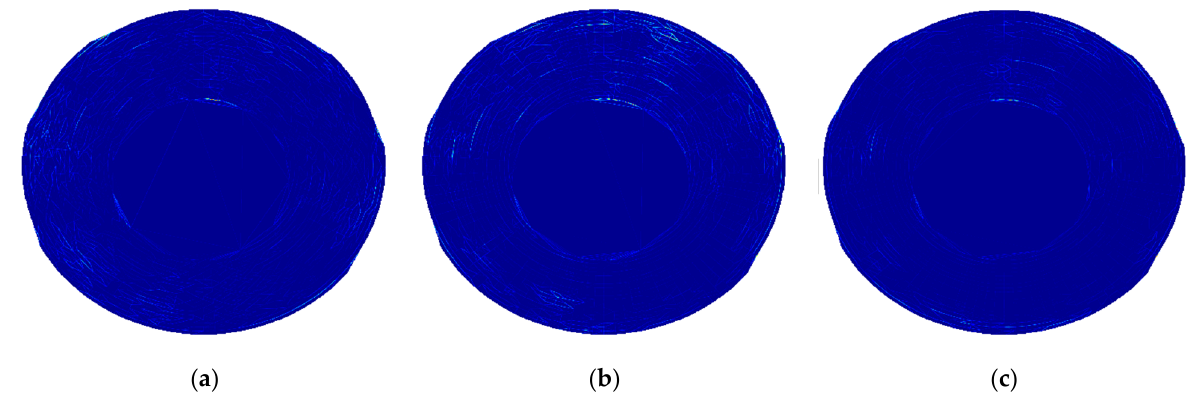
Figure 11. The post-processed mode shapes of the smaller disk: ( a – c ) subsequent considered mode shapes.